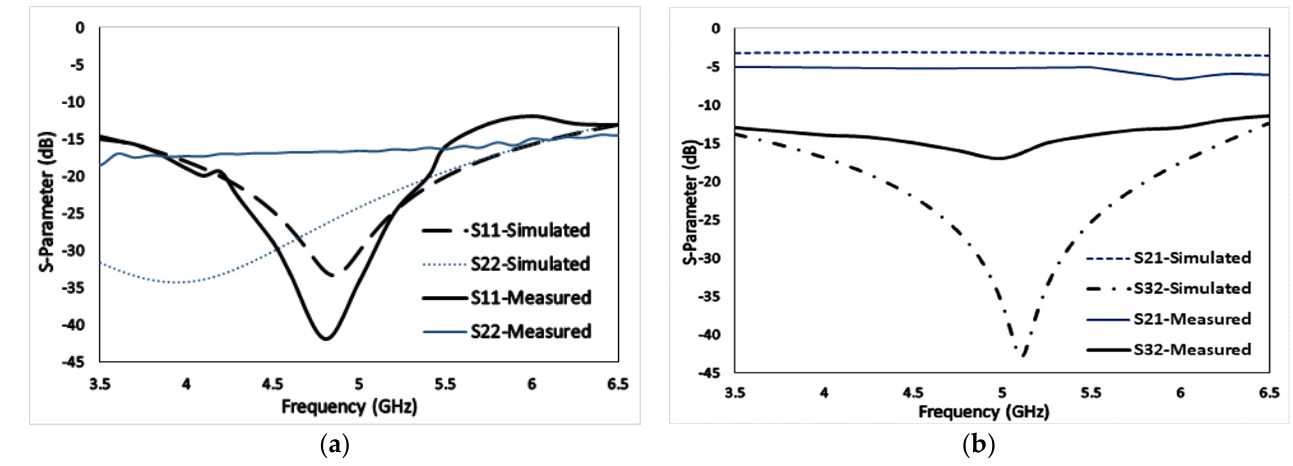
Figure 2. Shows the S − parameter response of the WPD ( a ) simulated and measured return loss ( S 11 ) at port − 1 and ( S 22 ) at port − 2, and ( b ) simulated and measured insertion loss ( S 21 ) between port − 1 and port − 2, and isolation loss ( S 32 ) between port − 2 and port − 3, respectively.